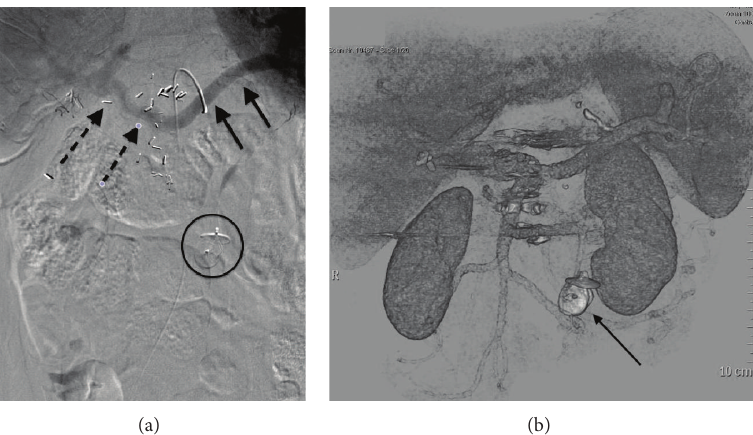
Figure 2: (a) Visceral phase angiography following injection of the splenic artery after occlusion of the portosystemic shunt with Amplatzer vascular plug (circled) demonstrates splenic vein (white arrows) draining antegrade into the portal vein (black arrows). (b) VR CT image shows the position of the Amplatzer plug (arrow) and successful embolization of the shunt (no longer visualized). Portal venous flow is now seen to and within the